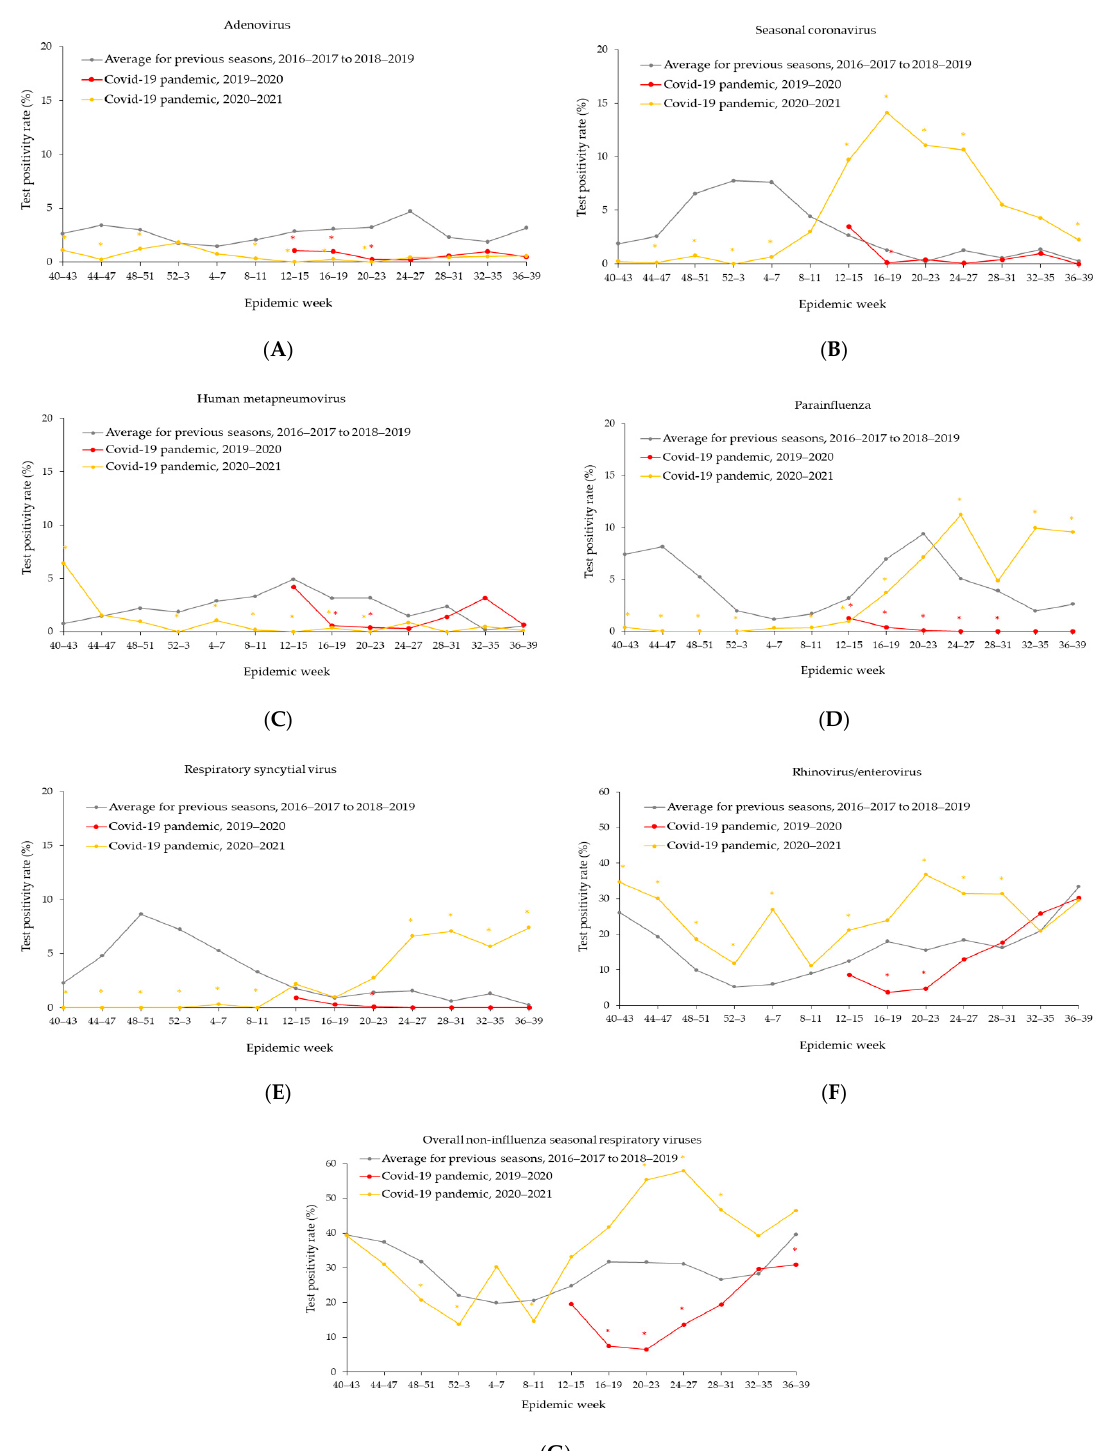
Figure 3. ( A – G ) Four-week average positivity rate of non-influenza seasonal respiratory viruses. Epidemic week is the week of the epidemiologic year for which there is the National